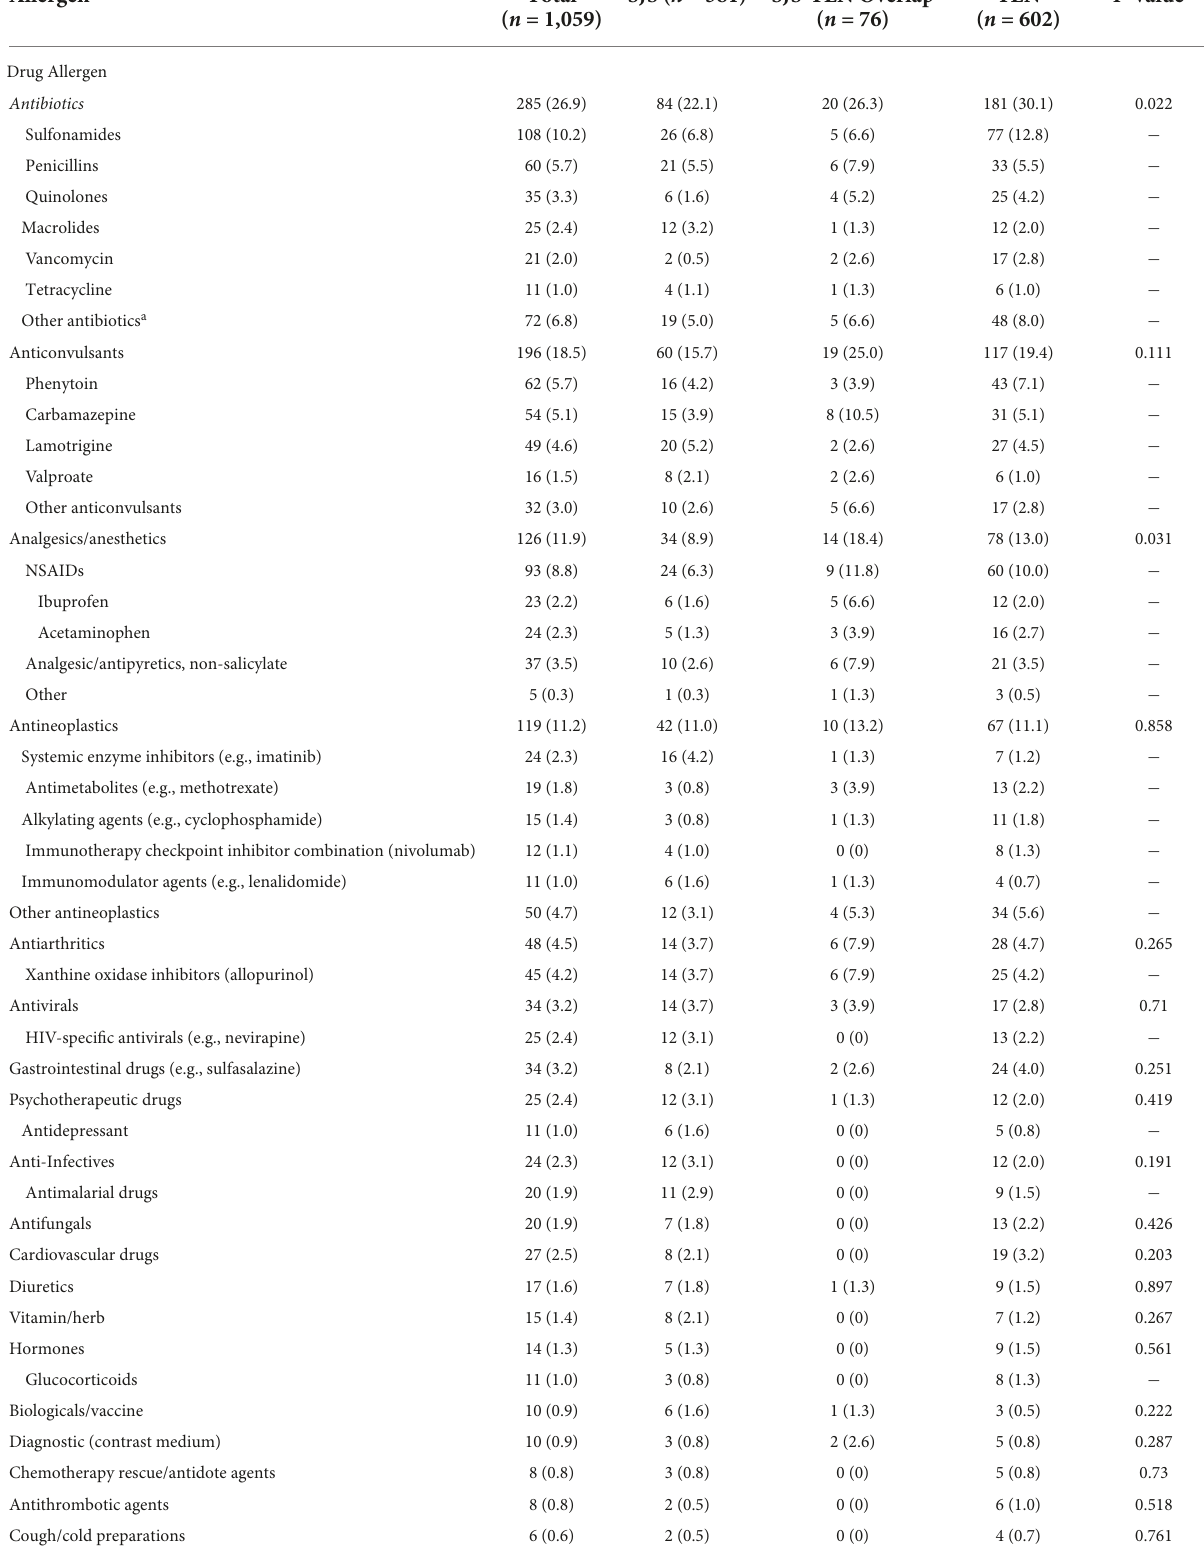
TABLE 4 Drug and non-drug allergens reported to cause SJS or TEN among reported cases from the